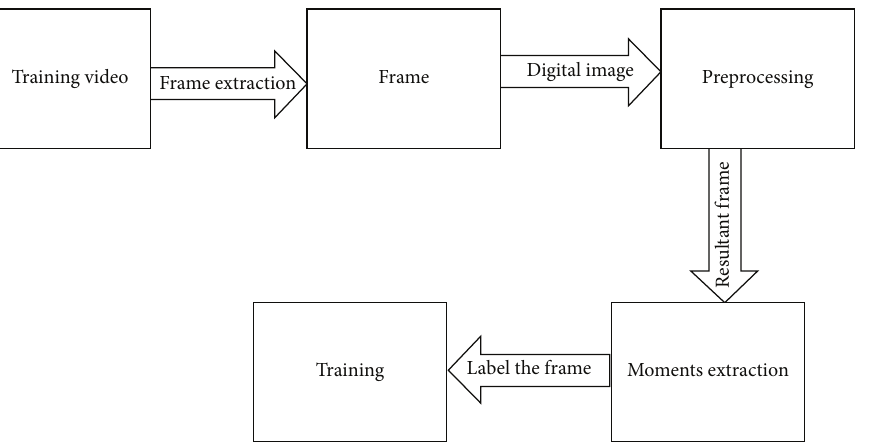
Figure 1: The steps of the training process.